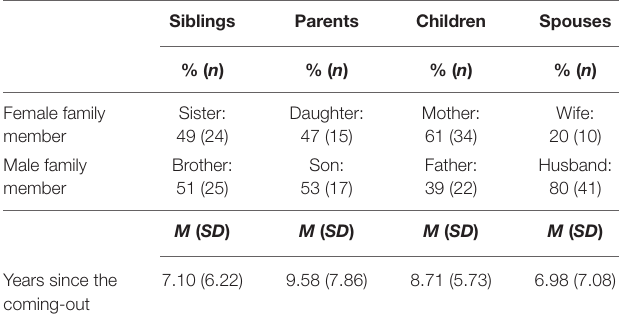
TABLE 2 | Number of family members with coming out and number of years since the coming